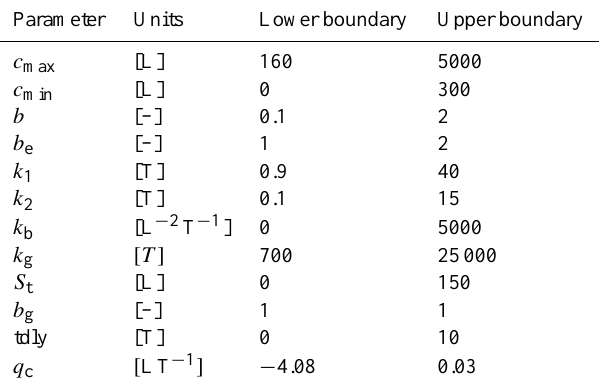
Table 1. Overview of the PDM parameters with indication of the lower and upper boundaries for catchments in